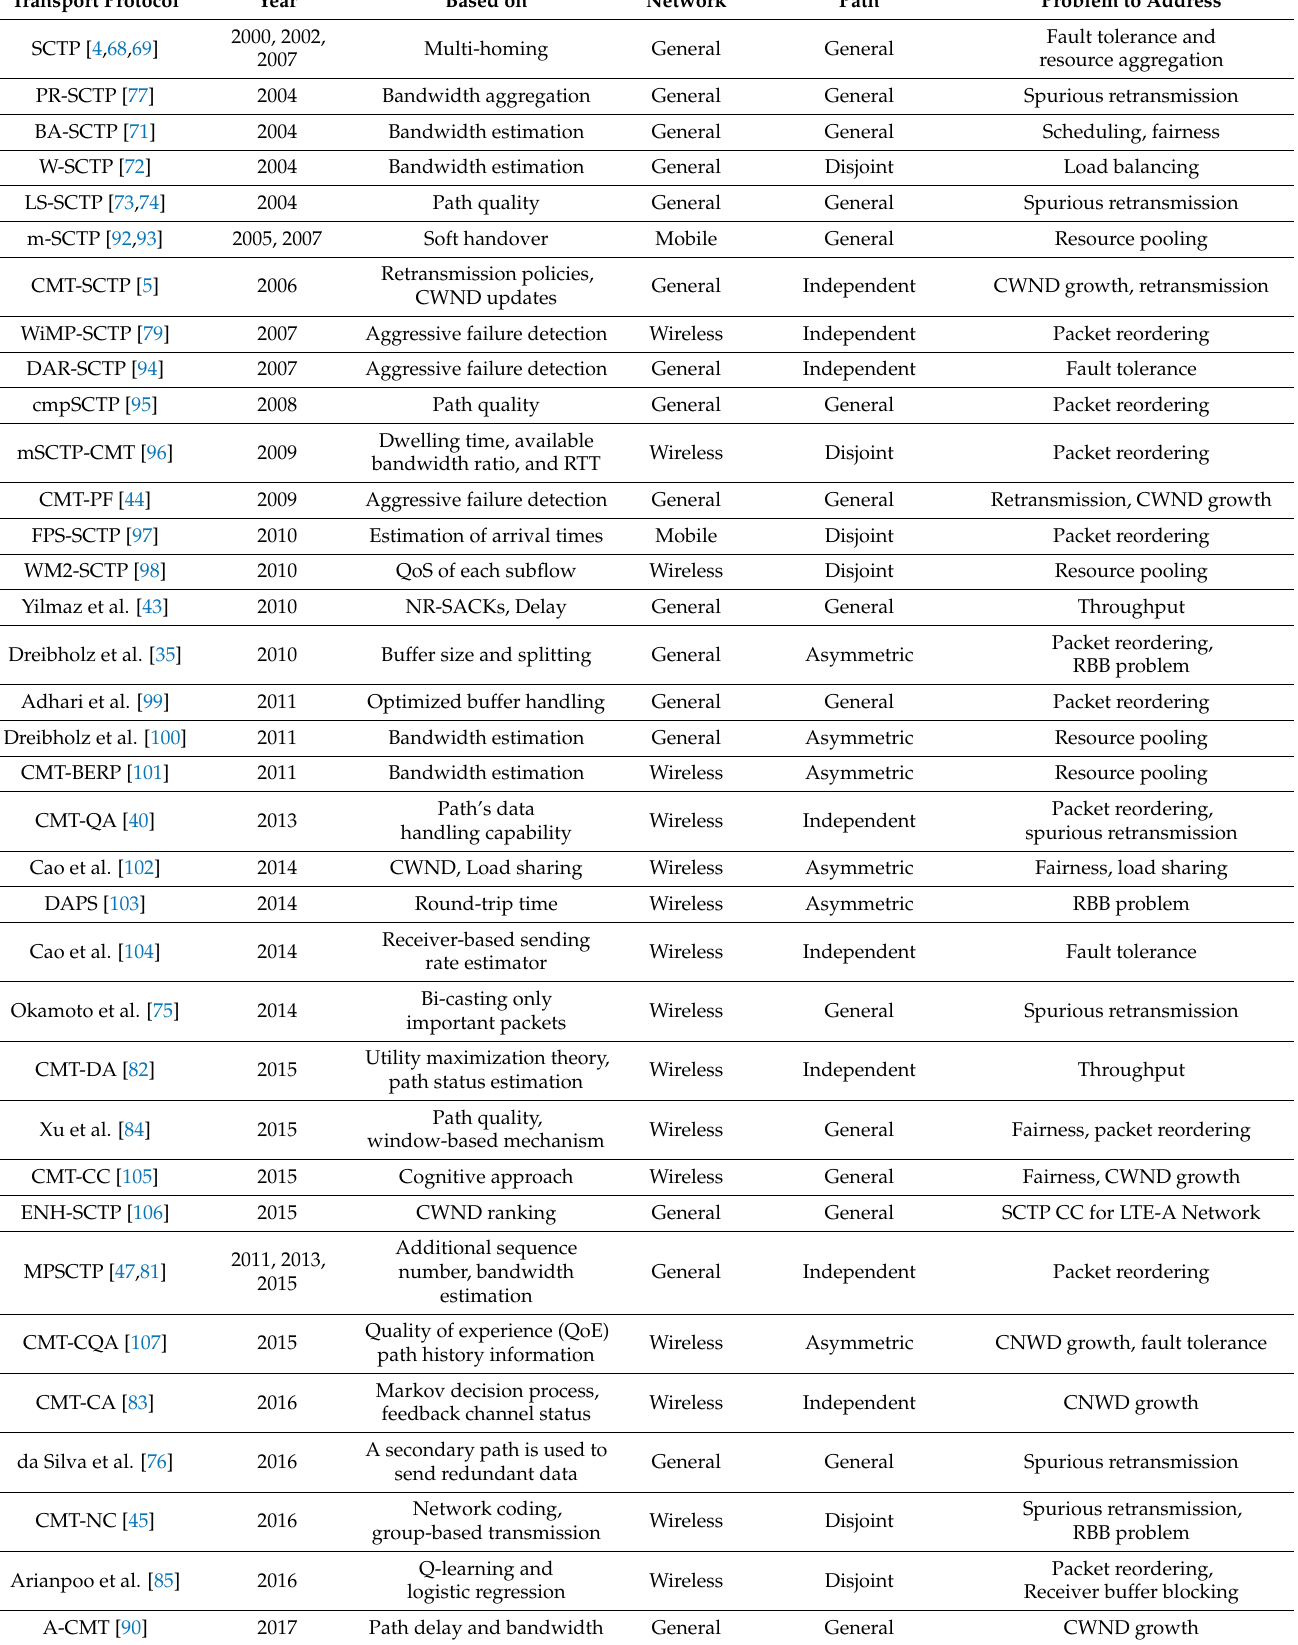
Table 1. SCTP and CMT-SCTP transport